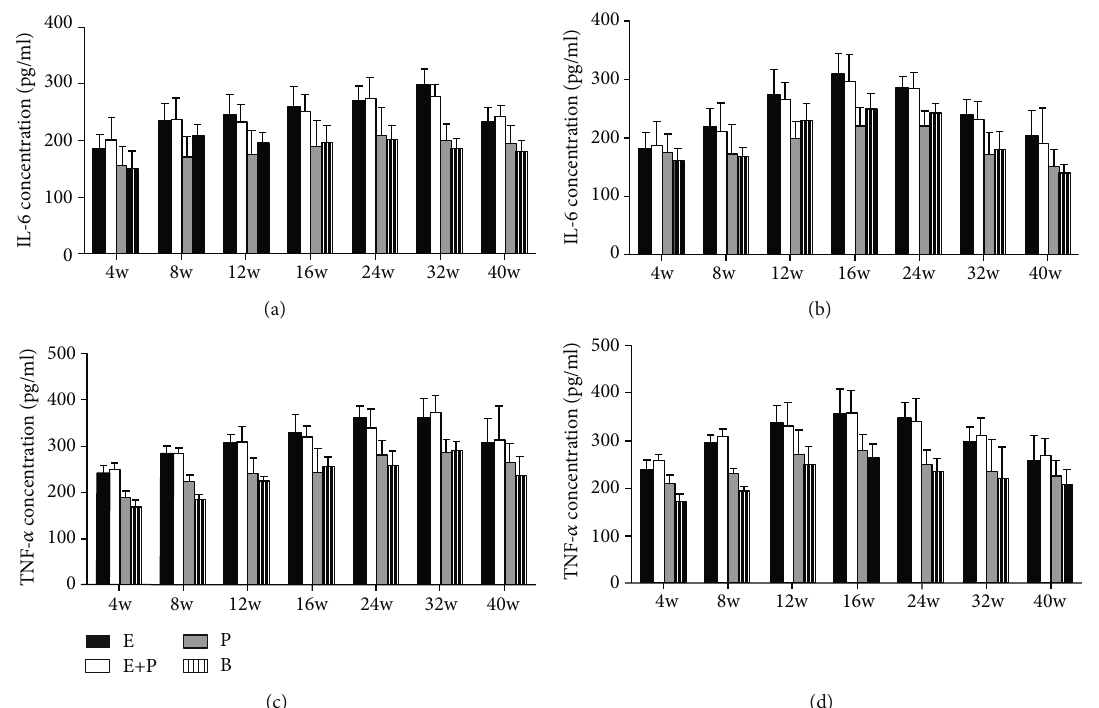
Figure 7: RT-PCR analysis of miR-132 and miR-134 (normalized to U6) in di ff erent groups. (a) miR-132 level of the left hemisphere. (b) miR-132 level of the right hemisphere. (c) miR-134 level of the left hemisphere. (d) miR-134 level of the right hemisphere. E: entire root group; E+P: entire root+posterior division group; P: posterior division group; B: blank control group. ∗∗∗ P < 0 : 001 . Data are expressed as mean ± SD (one-way ANOVA followed by